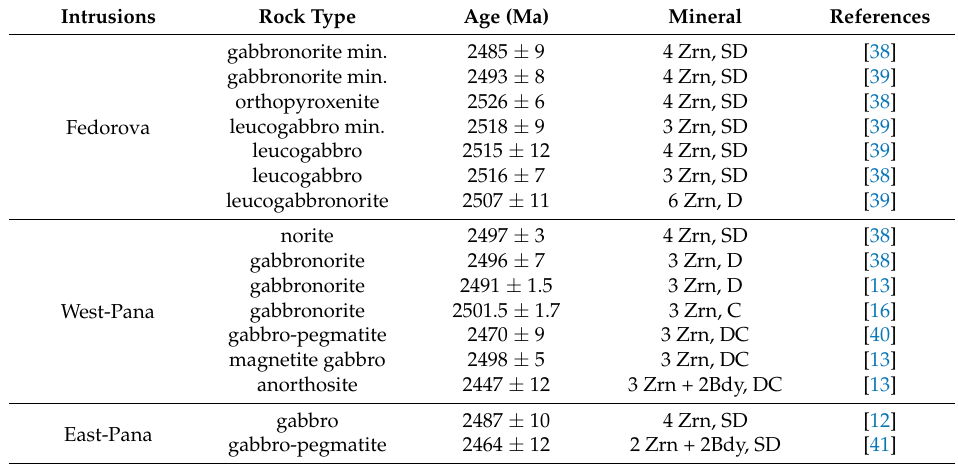
Table 2. Published isotope U-Pb rock ages of the Fedorova-Pana